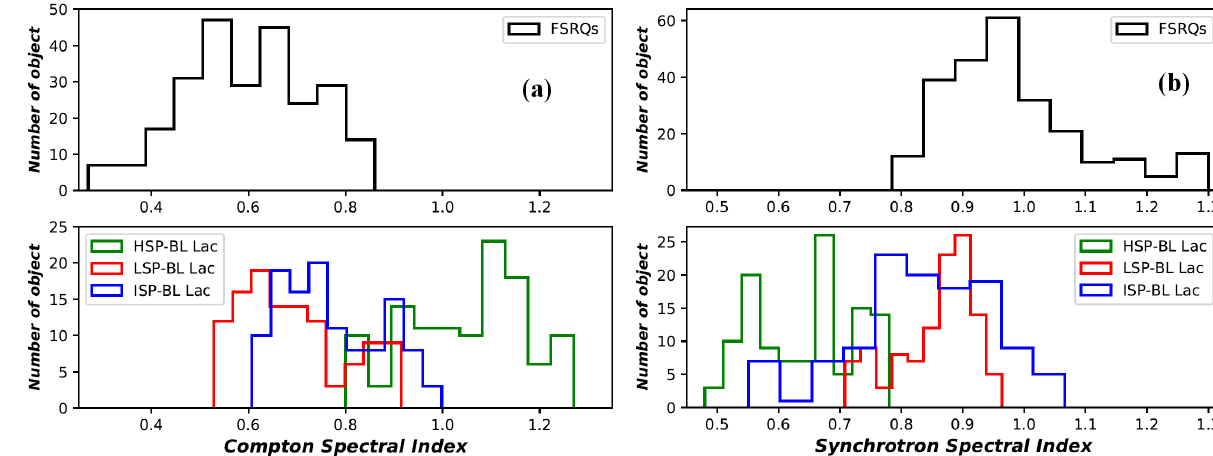
Figure 2. Distributions of (a) Compton (b) Synchrotron spectral indices for FSRQs and BL Lacs